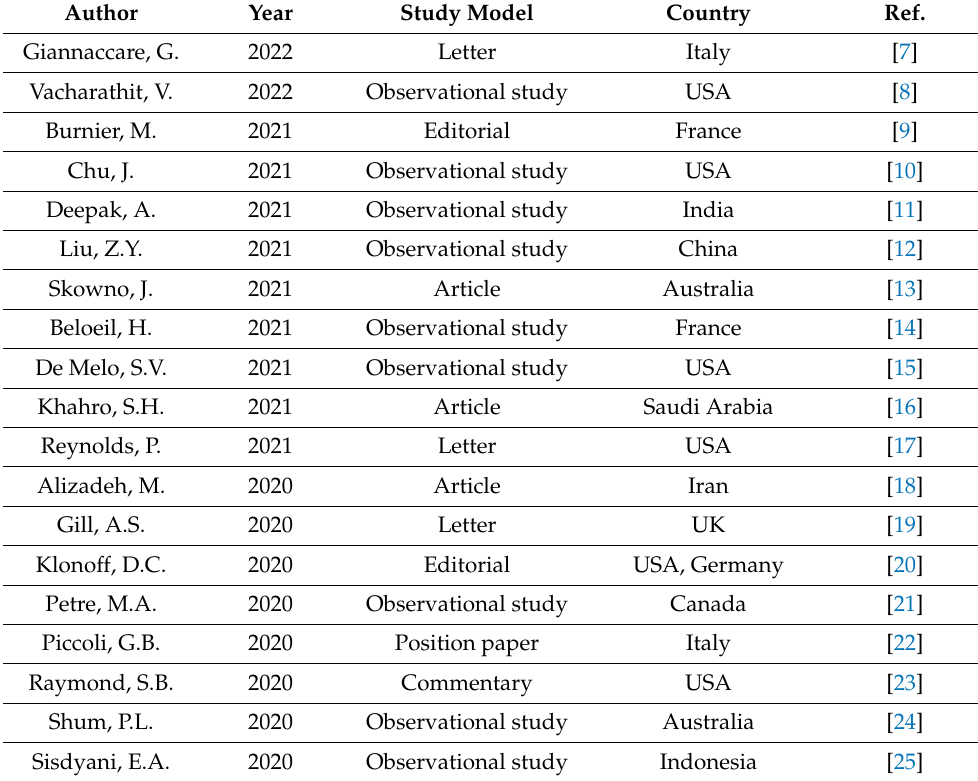
Figure 1. Flow-chart of the bibliographic research. Table 1. Included studies.